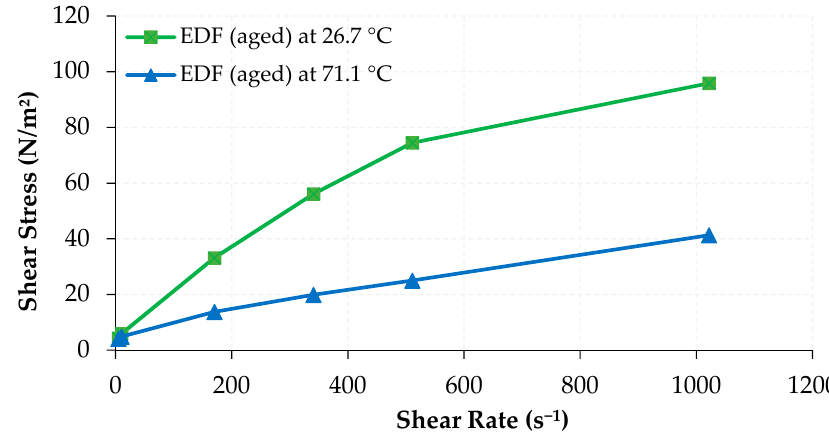
Figure 5. EDF consistency curves after aging.